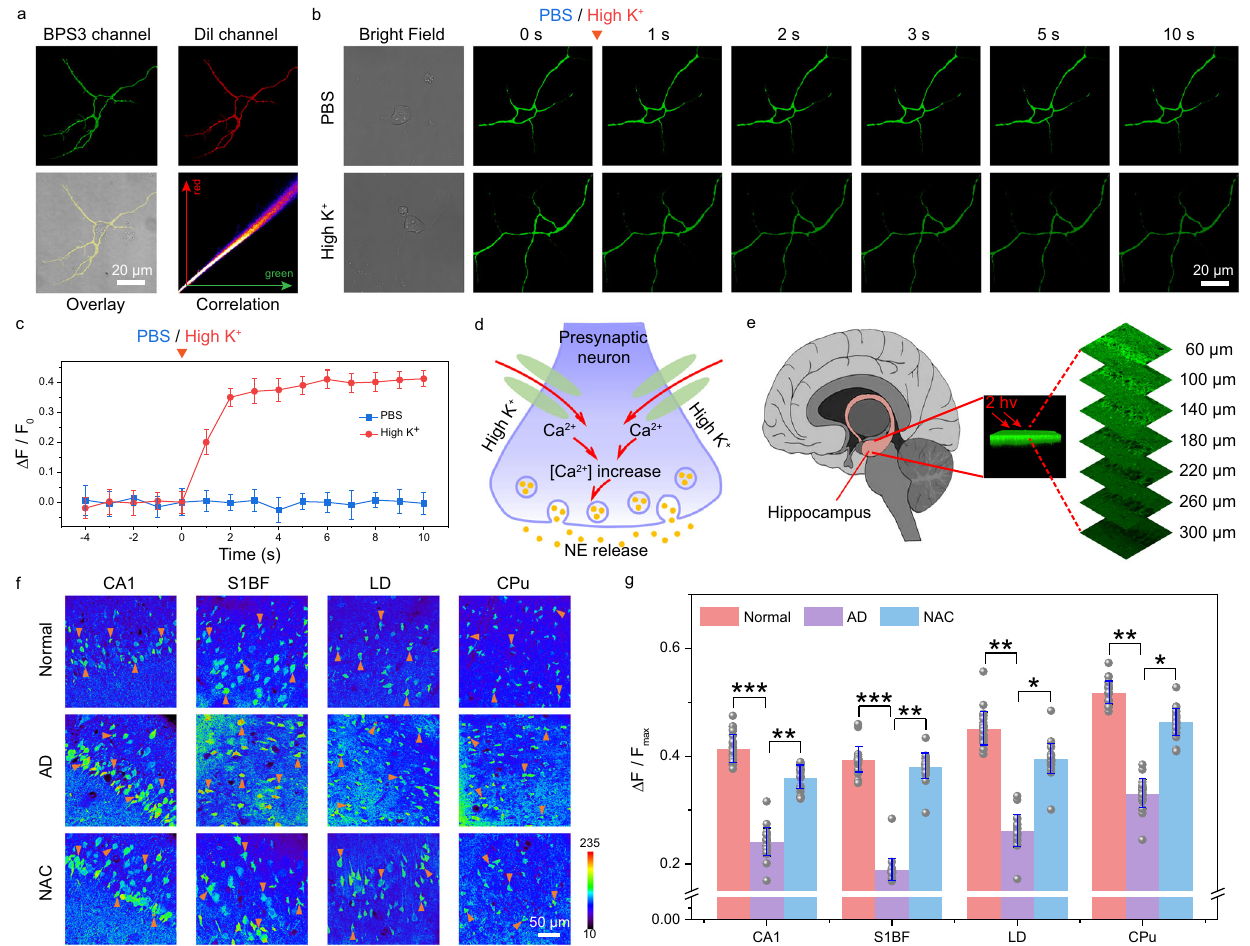
Fig. 5| Bioimaging performances.a Confocal fl uorescenceimages of neurons co- stained with BPS3 and a commercial membrane probe (DiI). Three independent experiments were repeated and similar results were obtained. b Time-lapse con- focal fl uorescence images of BPS3-incubated neurons stimulated by PBS buffer or high concentration of potassium, respectively. c Time-course of the fl uorescence variation rate ( Δ F/F 0 ) of neurons stimulated byPBS(Phosphate-Buffered Saline) or highconcentrationofpotassium,respectively(intervalof1s).Dataarepresentedas mean±S.D.Errorbars:S.D., n =5cells. d IllustrationofthepossibleprocedureofNE release upon stimulation with high concentration of potassium. e Three- dimensionaltwo-photonconfocal fl uorescenceimagesofthehippocampusregion in mouse brainlabeled with the BPS3probe,two-photonexcited at720nm. f Two-